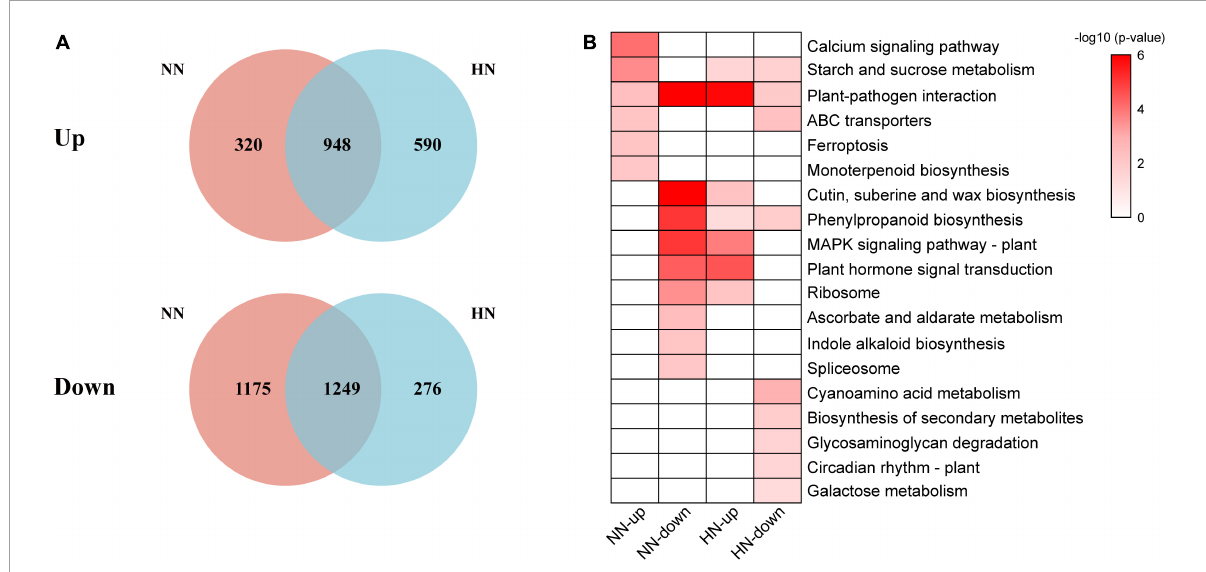
FIGURE5 Venn diagram and functional analysis of DEGs under different NH 4 + resupply concentrations. (A) Venn diagram of DEGs (upregulated and downregulated genes) under different NH 4 + resupply concentrations. (B) Significantly enriched KEGG pathways of specific DEGs under different NH 4 + resupply concentrations (Bonferroni’s test, p <